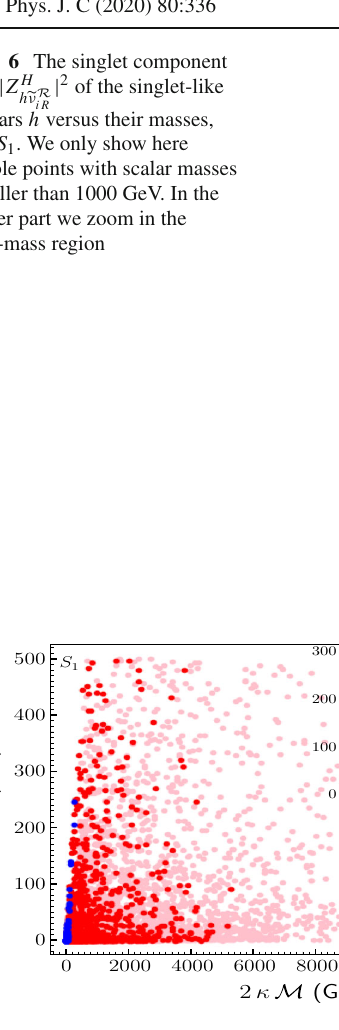
Fig. 7 Viable points of the parameter space for S 1 in the − T κ versus 2 κ M plane. The color code is the same as in Fig. 4. In the upper right we zoom in the region with blue points